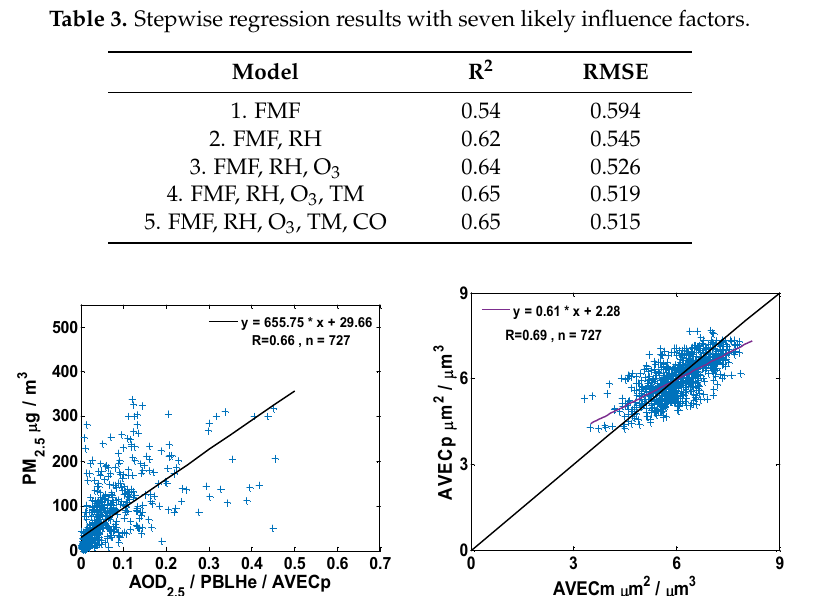
Figure 8. AVEC simulation results and particulate matter (PM) 2.5 -V 2.5 relationship (year = 2016, n =